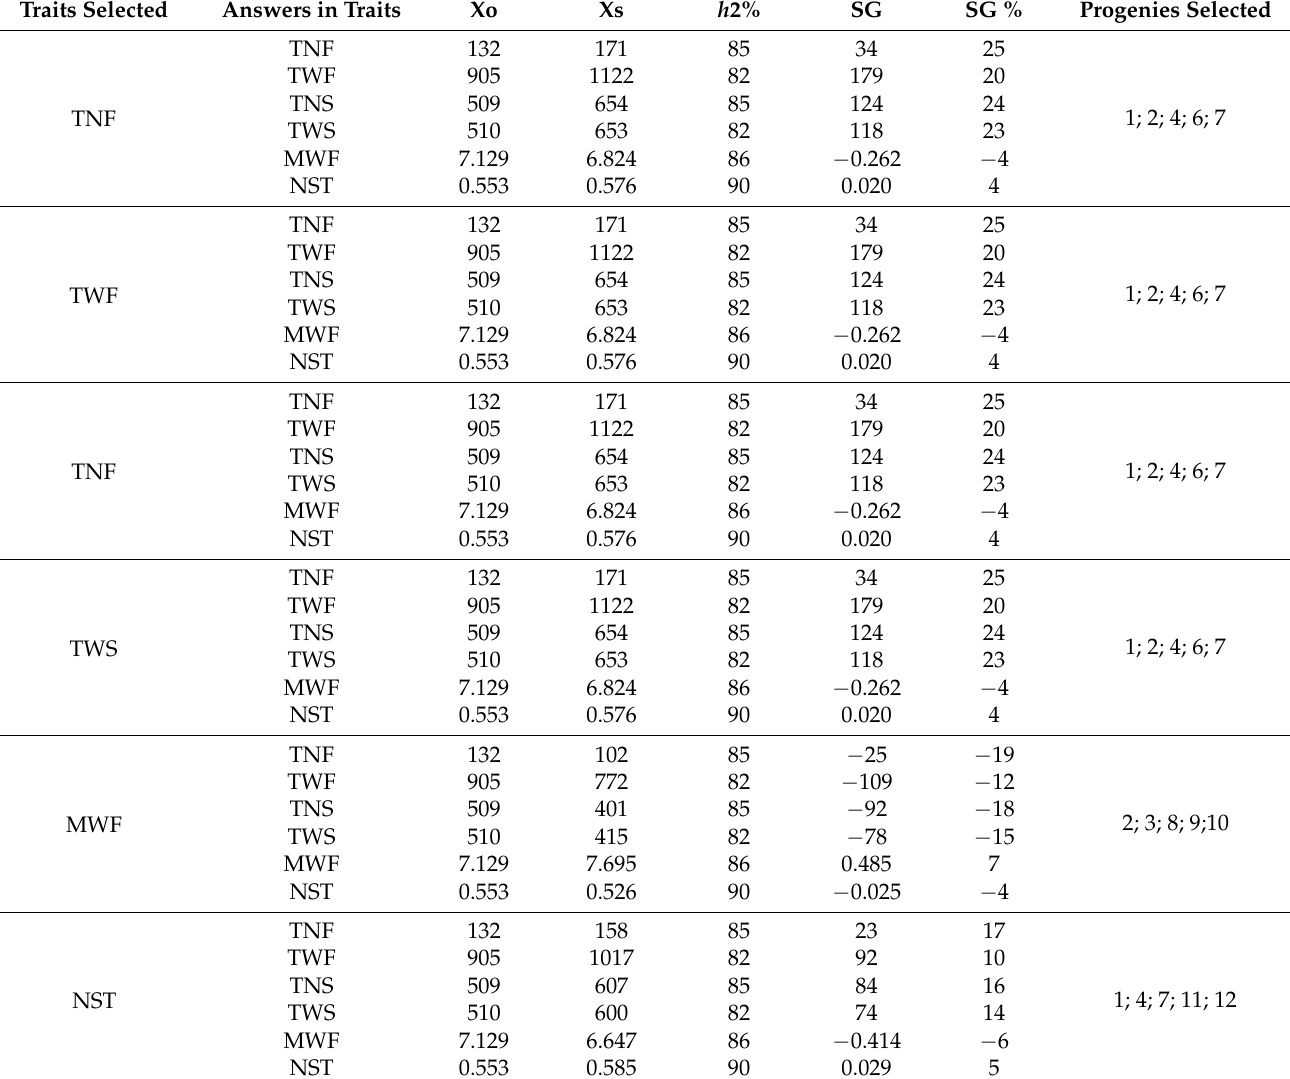
Table 5. Direct and indirect selection gains of yield traits and fruit quality in 12 sacha-inchi